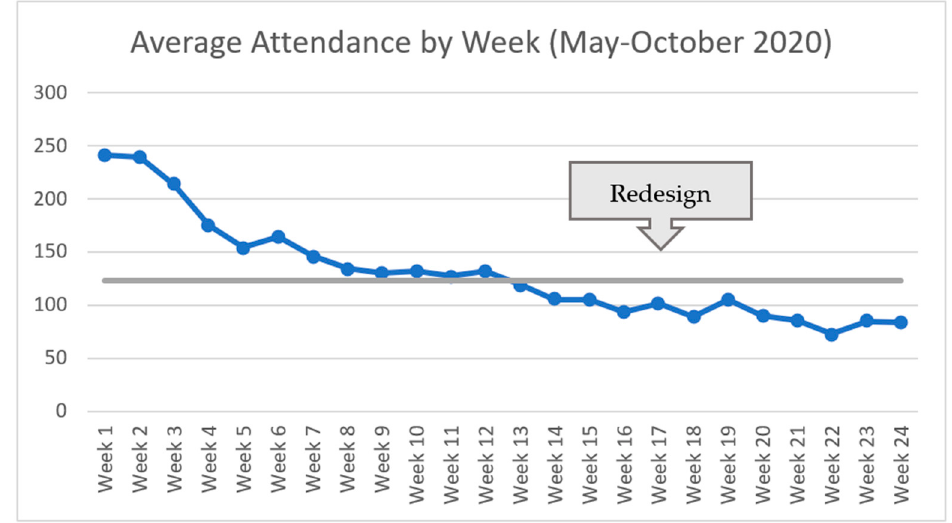
Figure 4. Average live RRN huddle attendance by week (May – October 2020).